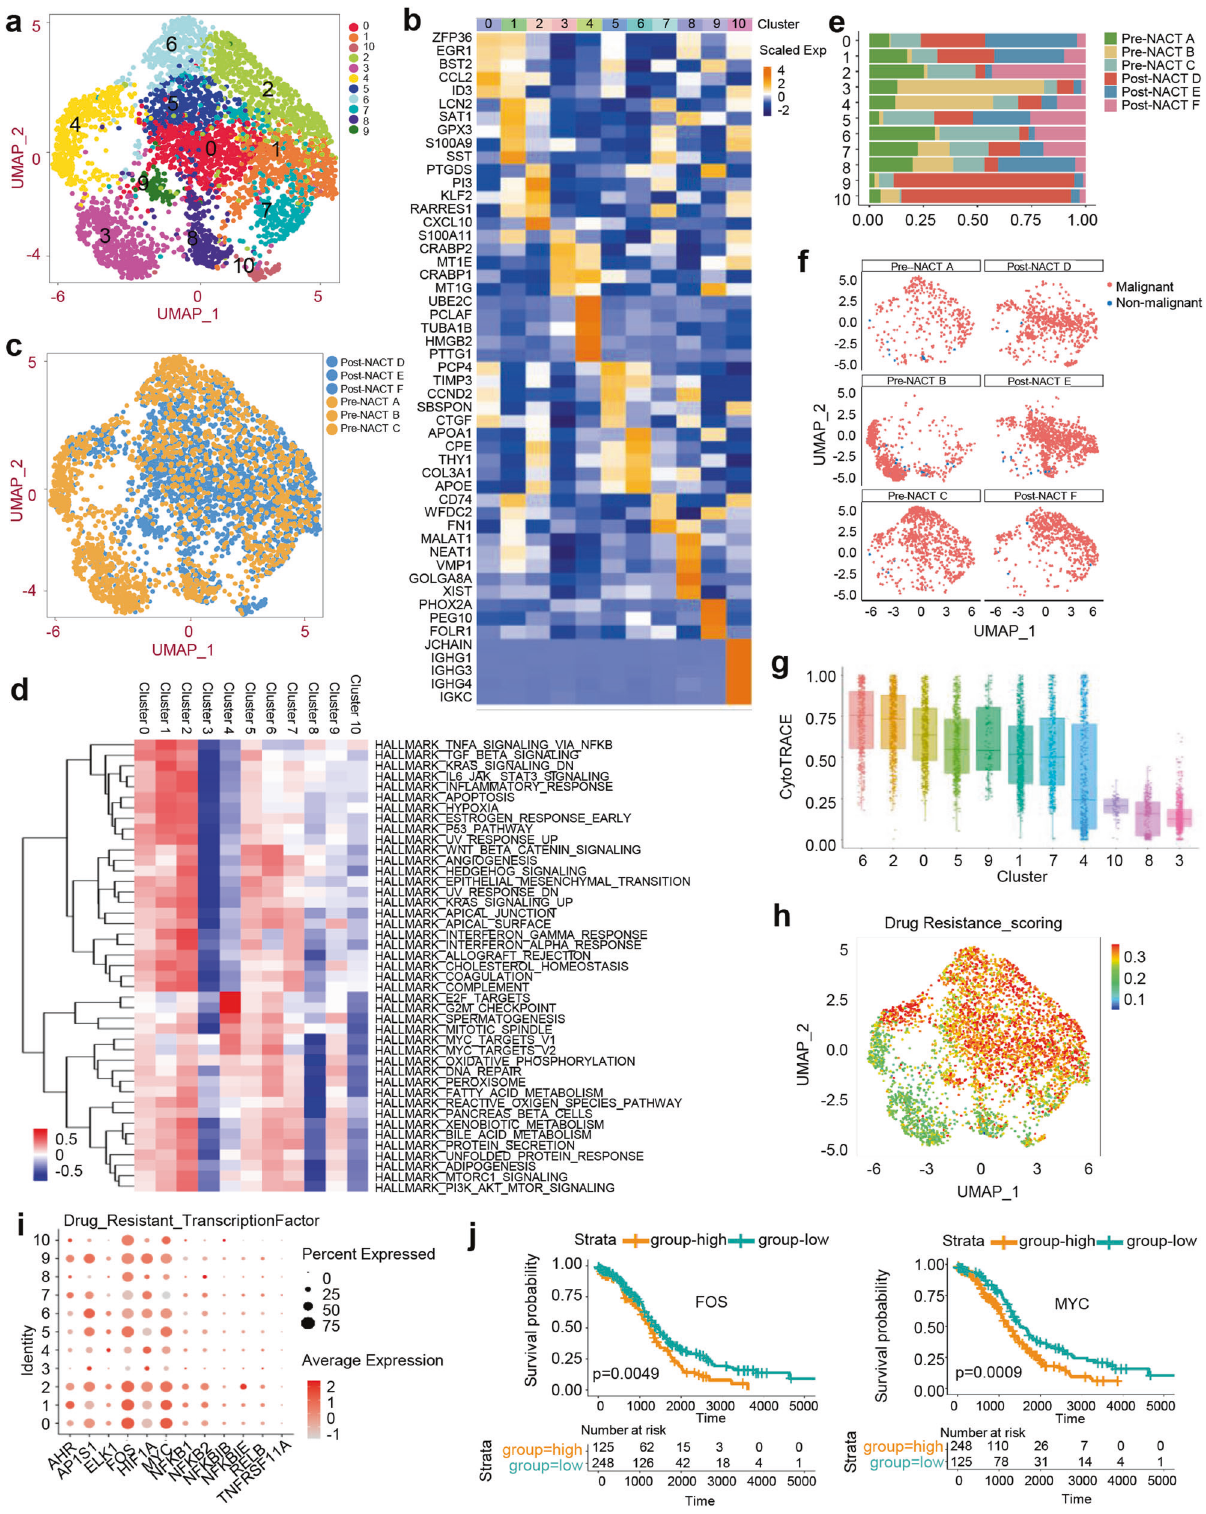
Fig. 3 The subtypes of epithelial cells in pre-NACT and post-NACT tumors. a UMAP projections of subclustered epithelial cells, labeled in different colors. b Heatmap showing the expression of marker genes in each indicated cell subcluster. c UMAP projection showing pre-NACT and post-NACT cells, clustered and color-coded according to the group. d Heatmap indicating the primary hallmark pathways in each subcluster. e Histogram indicating the proportion of subcluster cells in each analyzed sample. f UMAP plots showing the malignant and non- malignant epithelial cells colored by red or blue in each tumor sample. g CytoTRACE analysis of epithelial cells in each subcluster. h UMAP plots showing distinct drug resistance scores in each subcluster. i Gene bubble plots showing different expression levels of drug resistant- related transcription factors in each subcluster. j Kaplan – Meier survival curves showing the association of FOS and MYC expression with overall survival in patient with HGSCs (from TCGA). Log-rank p values are